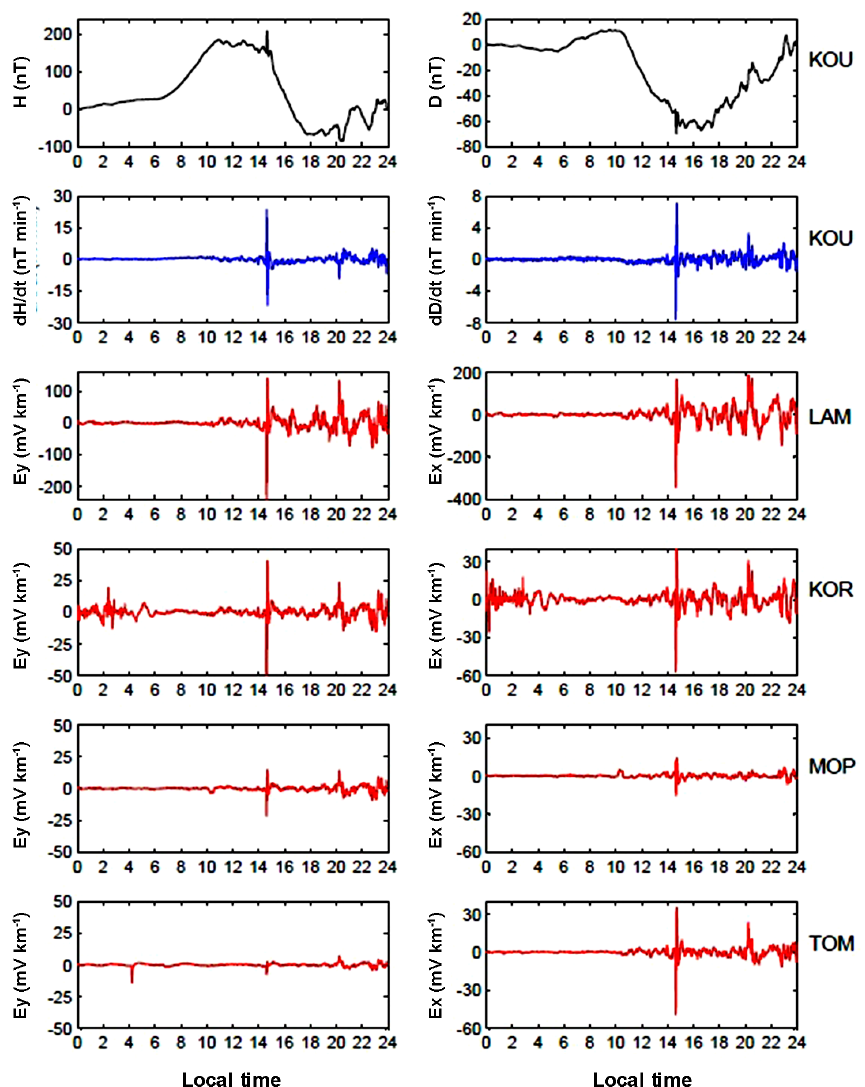
Figure 6. Geo-electric field variations during the 17 February 1993 storm. The top panels show the time derivatives of H (left) and D (right) and the other panels show variations in the E x (left column) and E y (right column) at LAM, NIE, SIK, SAN and